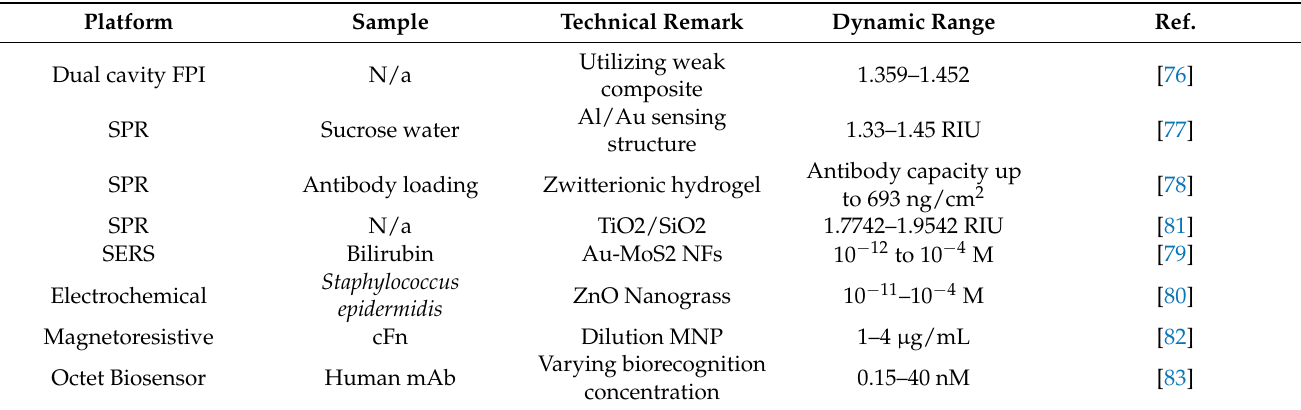
Table 2. Summary of the dynamic range enhancement.